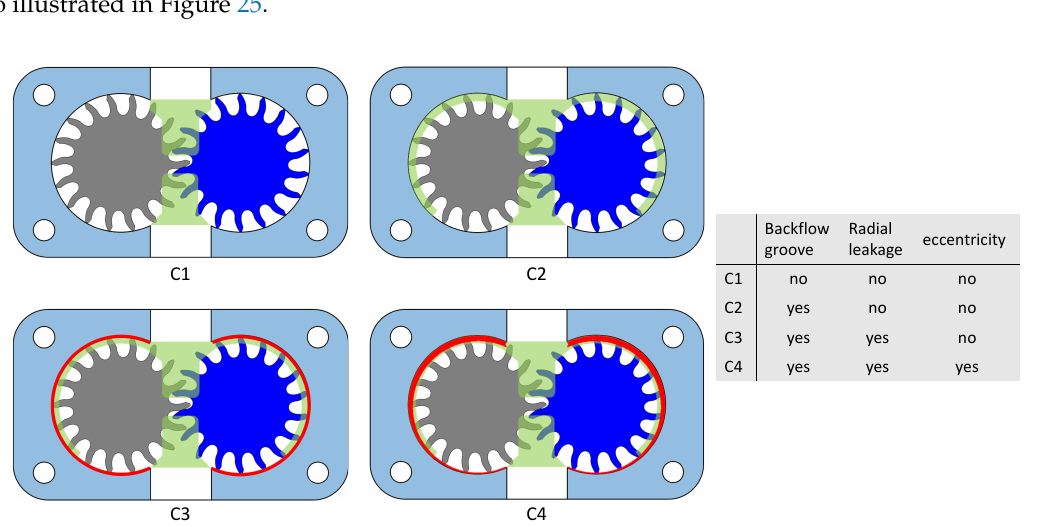
Figure 25. The four test cases considered for the analysis of the pressurization